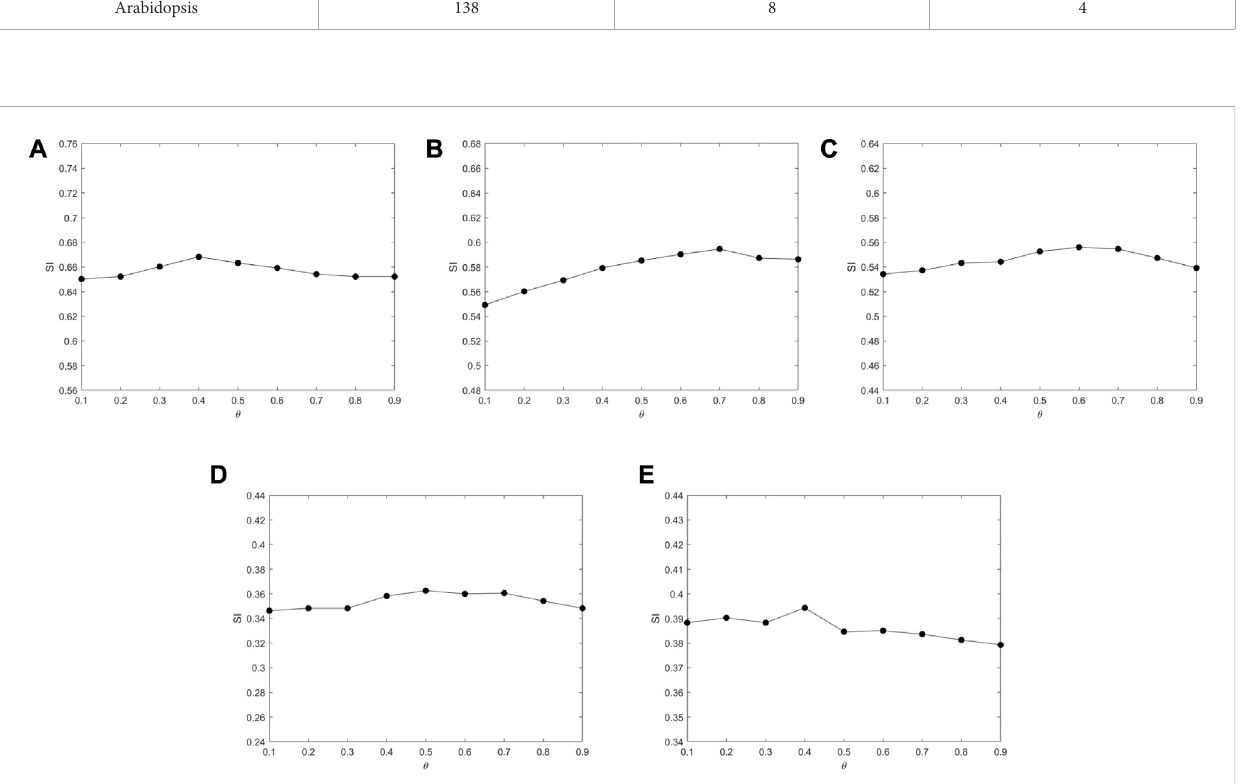
FIGURE 4 The impactofparameter θ on SI testedon differentdatasets. (A) YeastGalactoseMetabolism (B) YeastCell Cycle (C) YeastSporulation (D) Serum (E)